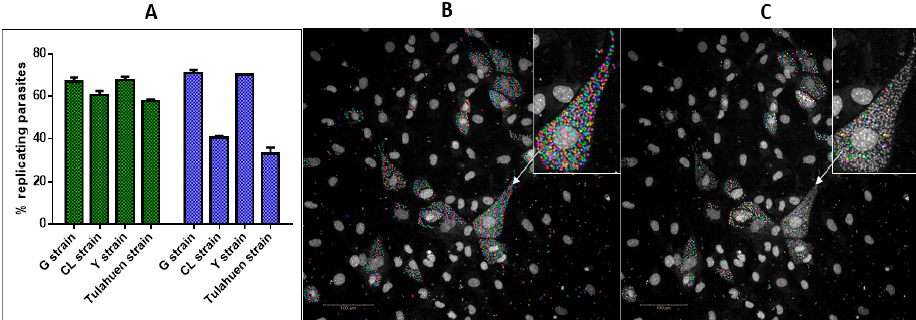
Figure 4. Intracellular replication of four T. cruzi strains, detected with the nucleoside analogue 5-ethynyl-2’-deoxyuridine following 48 and 72 h incubation. ( A ) The percentage of replicating intracellular parasites following 48 h (green) and 72 h incubation (blue). ( B ) Hoechst identification of intracellular Tulahuen parasites, following 72 h incubation ( C ) EdU identification of replicating Tulahuen parasite from the same cells as shown in ( A ). In ( B , C ) the image inset shows the difference in Hoechst and EdU identified parasites within a cell. Images taken at 20× magnification on a Phenix imaging system (PerkinElmer).